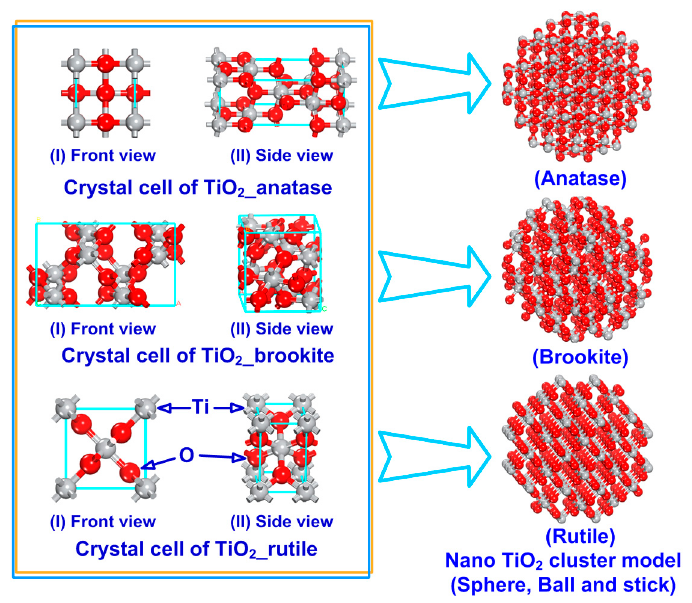
Figure 7. The molecular model of nano-TiO 2 .